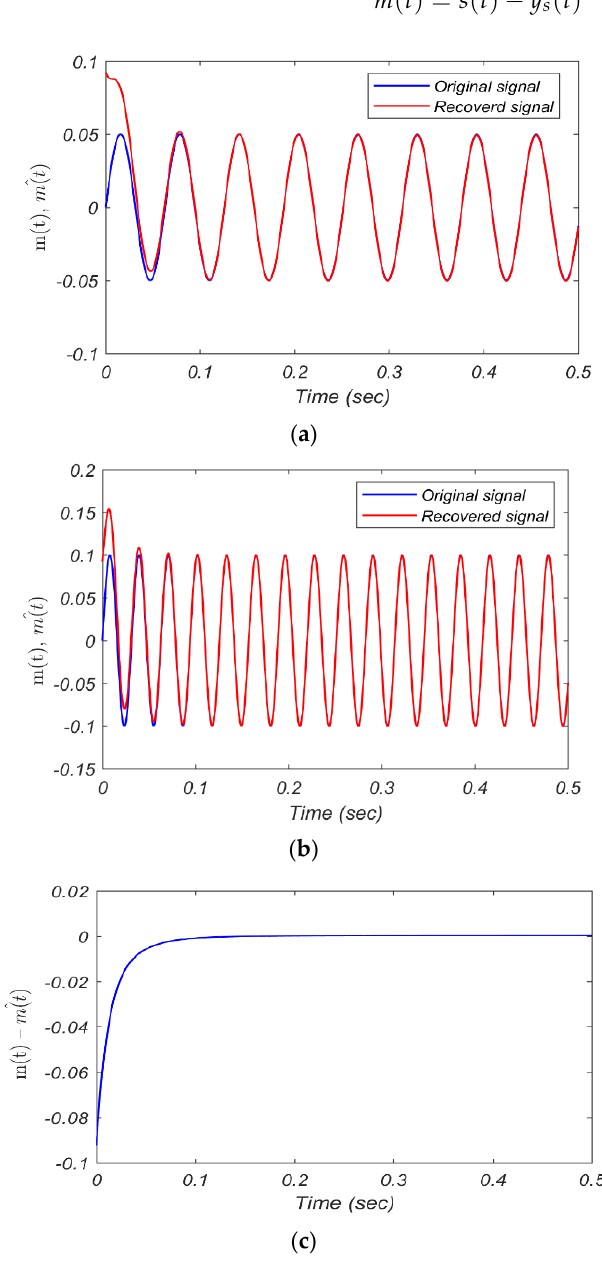
Figure 9. The secure communication signals: ( a ) the original signal and recovered signal with A = 0.05 and w = 100 rad/s; ( b ) the original signal and recovered signal with A = 0.1 and w = 200 rad/s; ( c ) the error difference between the original and retrieved signal.